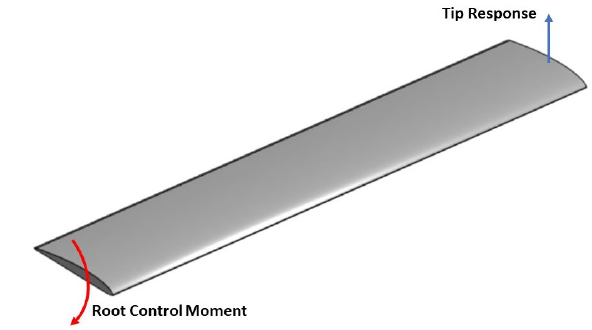
Figure 12. A simplified representation of wing control.